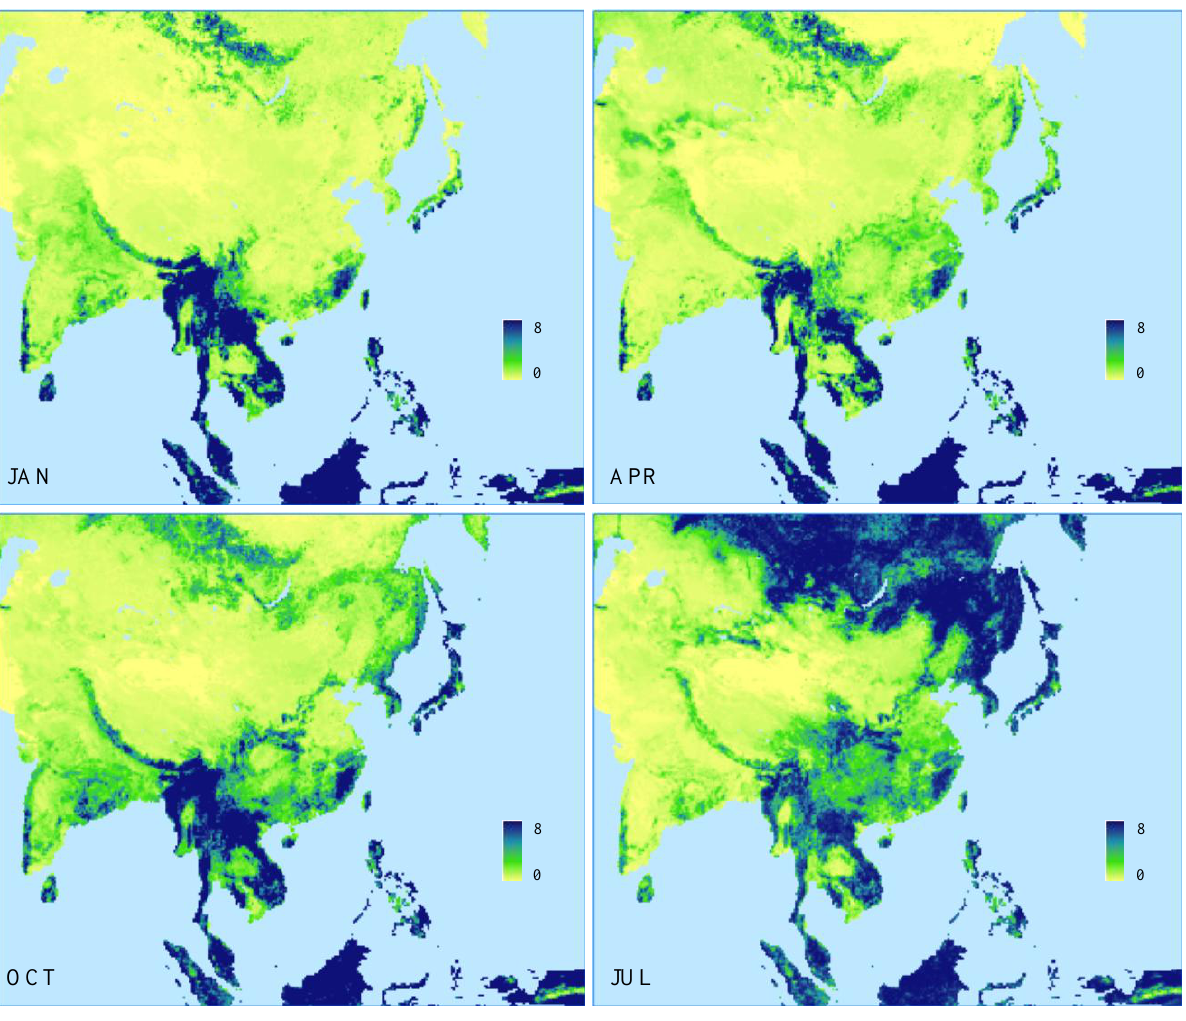
Figure 6. The geographic distributions of mean LAI based on the original 1981–1999 AVHRR climatology data in January, April, July, and October over the Asia RCM